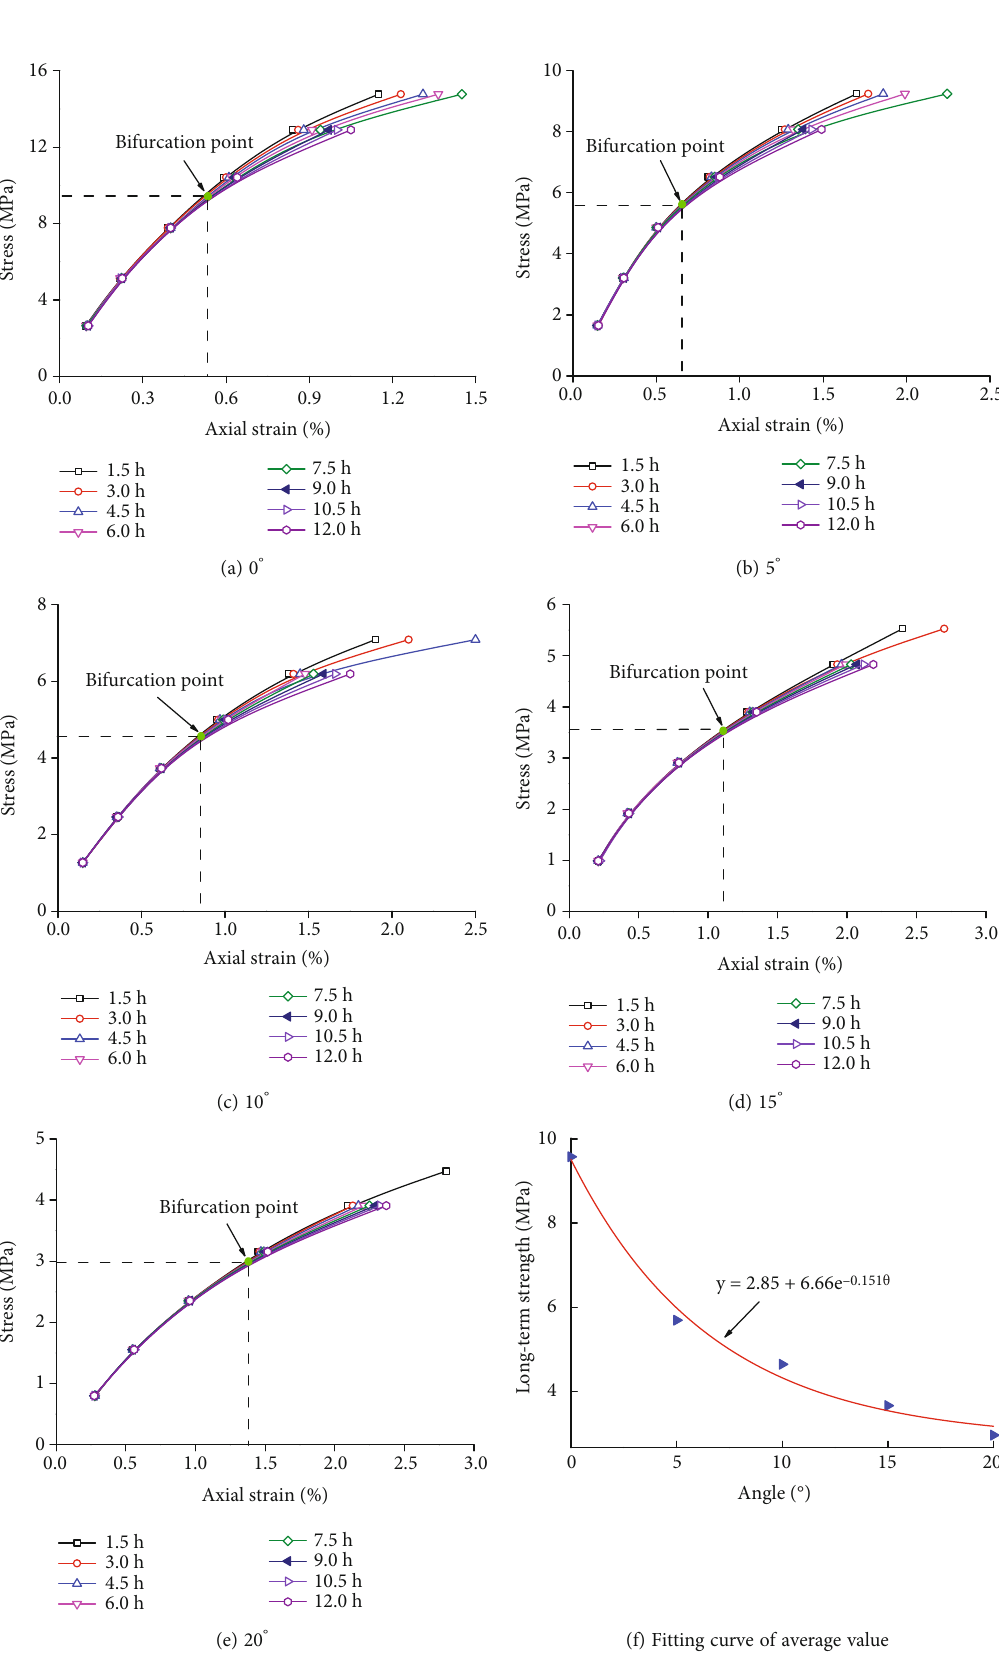
Figure 10: The LTS of coal specimens under various inclination